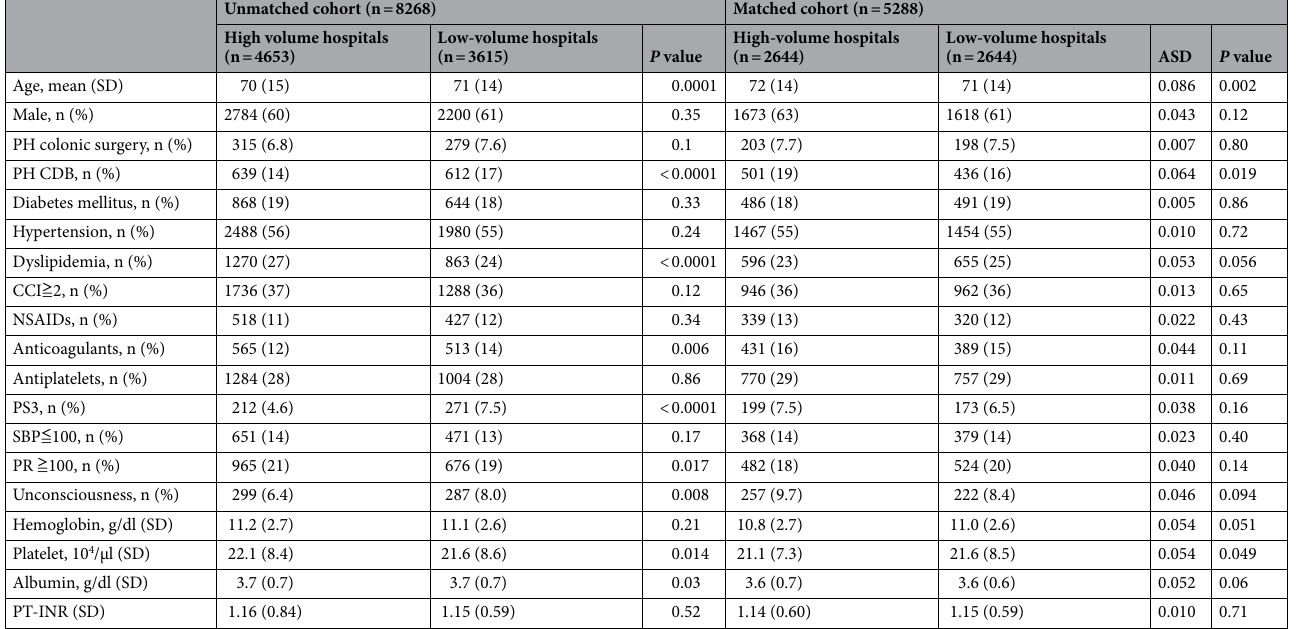
Table 1. Characteristics of patients with acute hematochezia in unmatched and matched cohorts: high- volume versus low-volume hospitals. A two-tailed P -value < 0.05 was considered to indicate